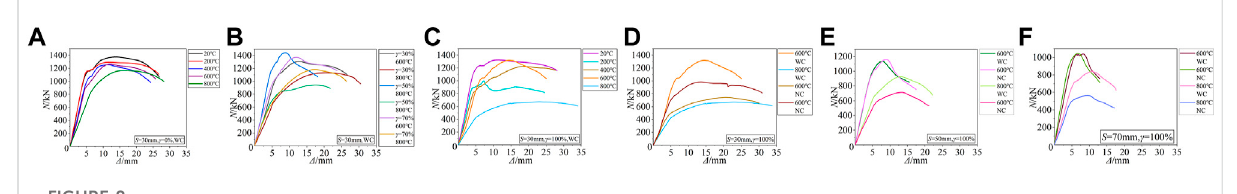
FIGURE 8 Load-displacement curves. (A) S = 30 mm, γ = 0%, WC; (B) S = 30 mm, WC; (C) S = 30 mm, γ = 100%, WC; (D) S = 30 mm, γ = 100%; (E) S = 50 mm, γ = 100%; (F) S = 70 mm, γ =